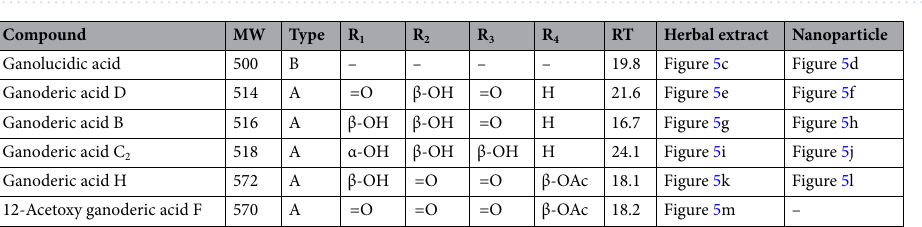
Table 3. Compounds identified in nanoparticles and extracts of Ganoderma by LC–MS. R 1 , R 2 , R 3 ,R 4 are functional groups that are replaced in Fig. 5n.